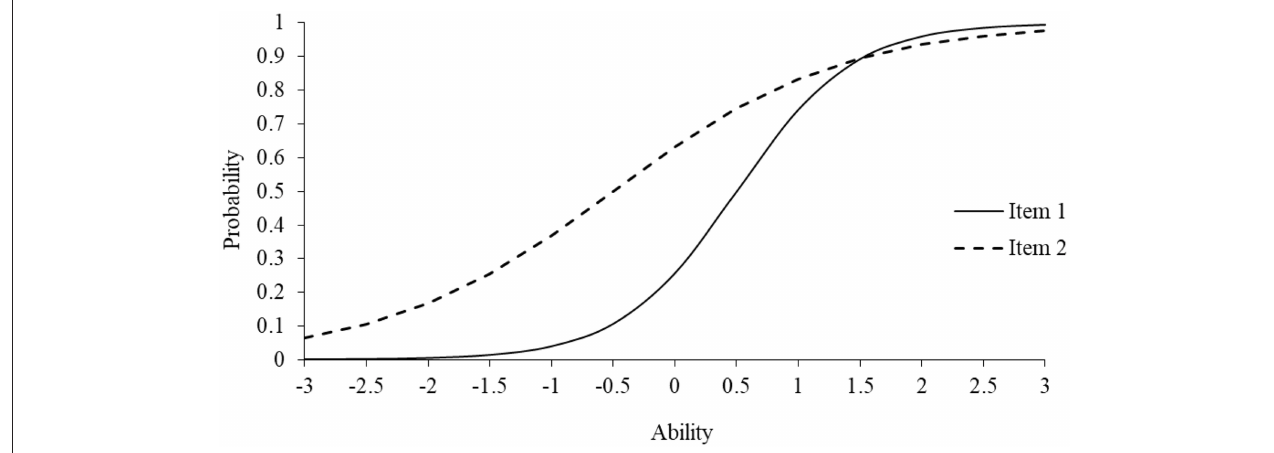
FIGURE 1 | Item characteristic curve for 2-PL